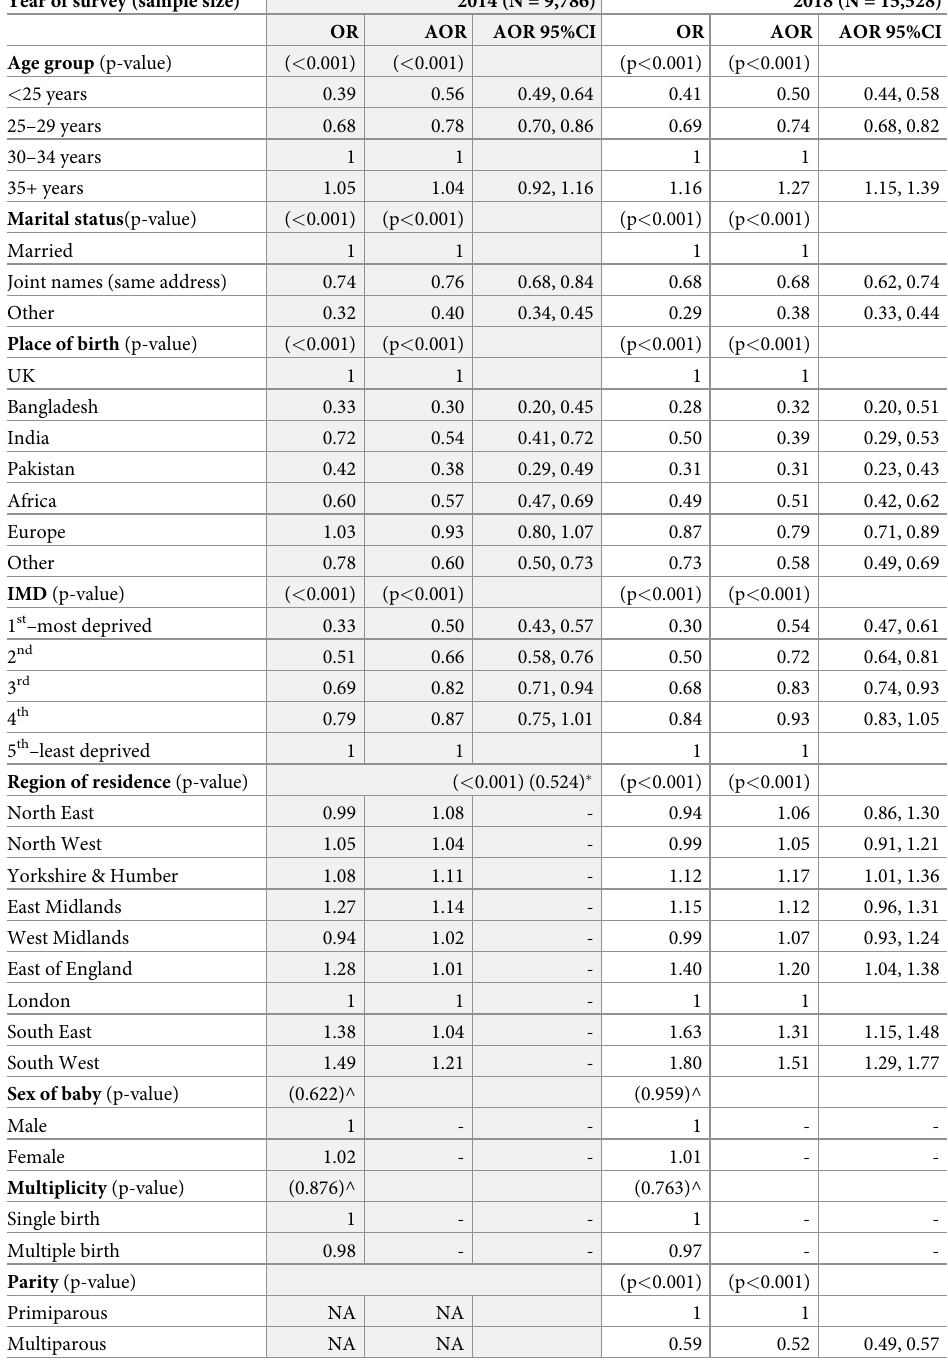
Table 2. Crude and adjusted odds ratios with 95% confidence intervals for association between demographic characteristics and response to the 2014 or 2018